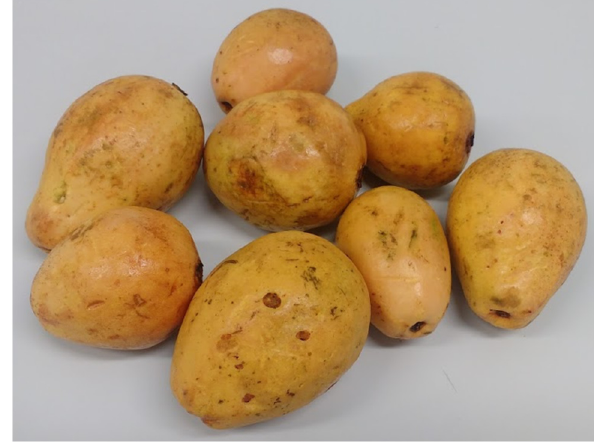
Figure 5. Photography of selected FPGs.